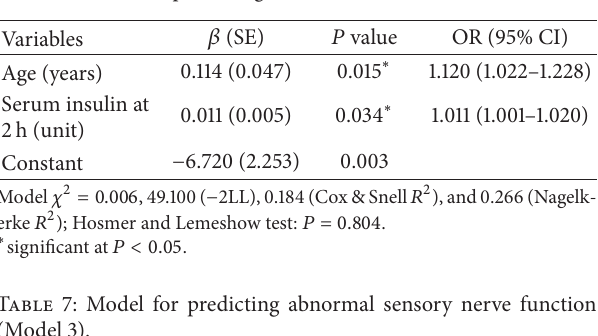
Table 6: Model for predicting ≥ 2 motor nerves involved (Model 2).